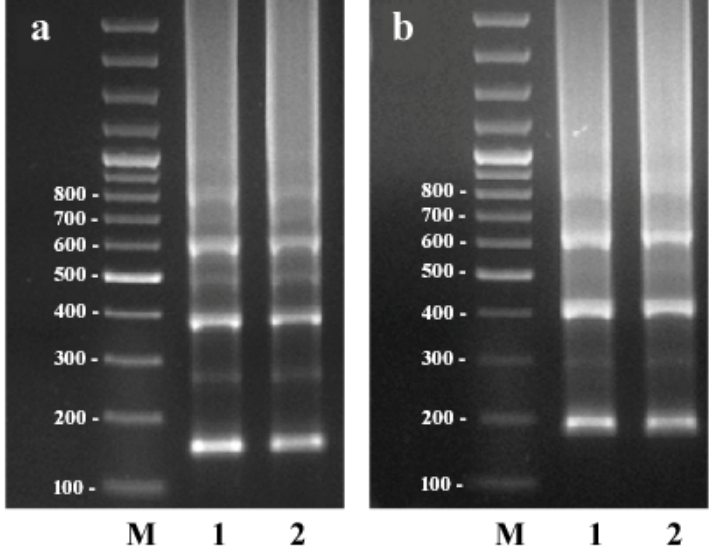
Figure 2. The results of PCR experiments with CS-237f/CS-237r1 ( a ) and CS-237f/CS-237r2 ( b ) primer pairs. 1 —C. sativa male; 2 —C. sativa female; M —molecular weight marker with 100 bp steps.